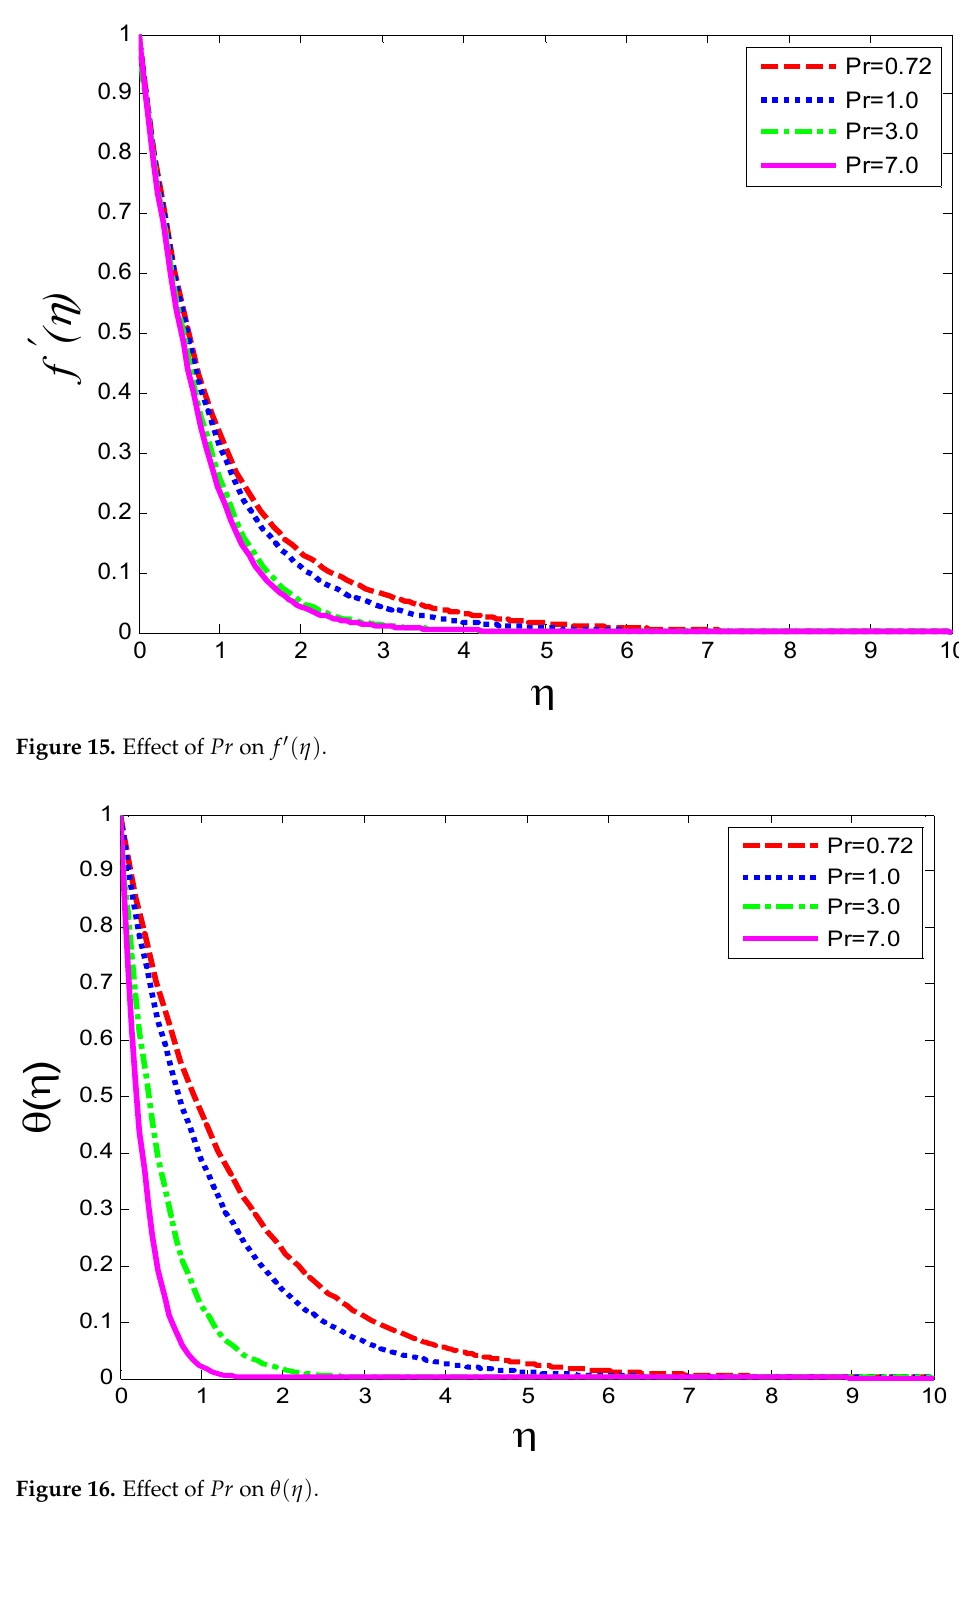
Figure 14. Effect of 𝐹𝑟 on 𝜃(cid:4666)𝜂(cid:4667) .